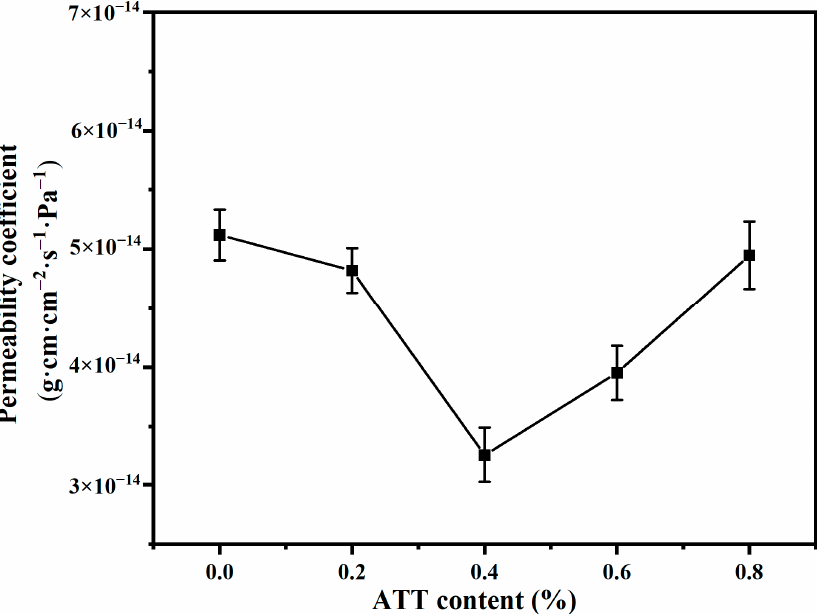
Figure 9. Variation in water permeability coefficients for MPP and MPP/ATT nanocomposite materials.